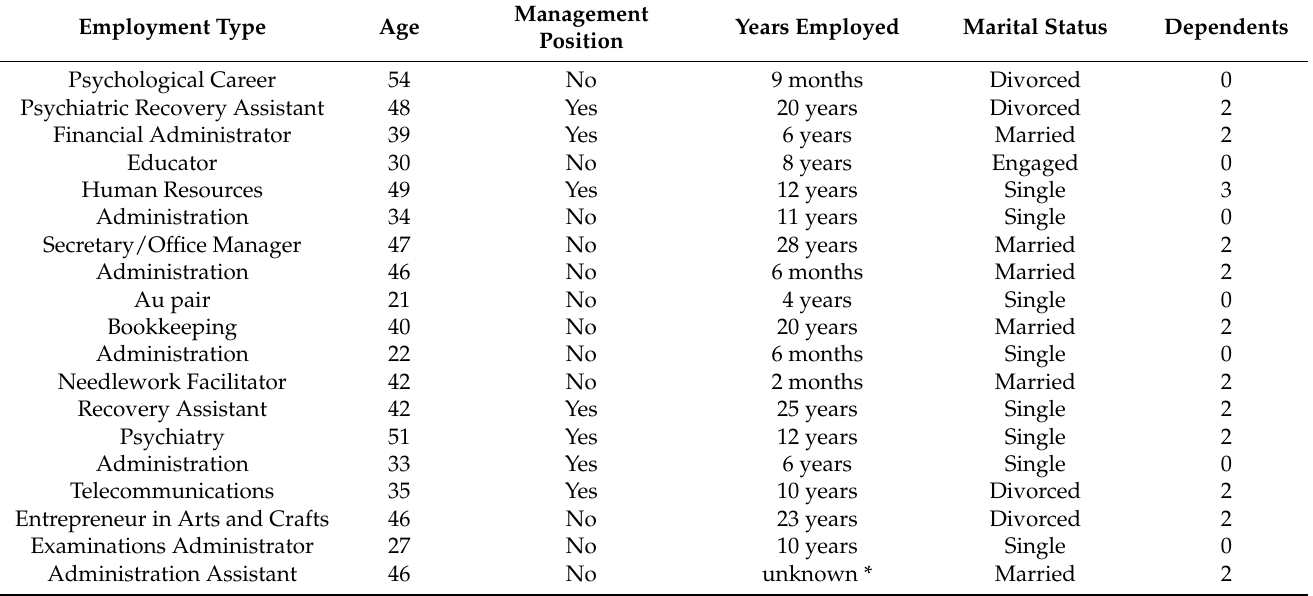
Table 1. Description of